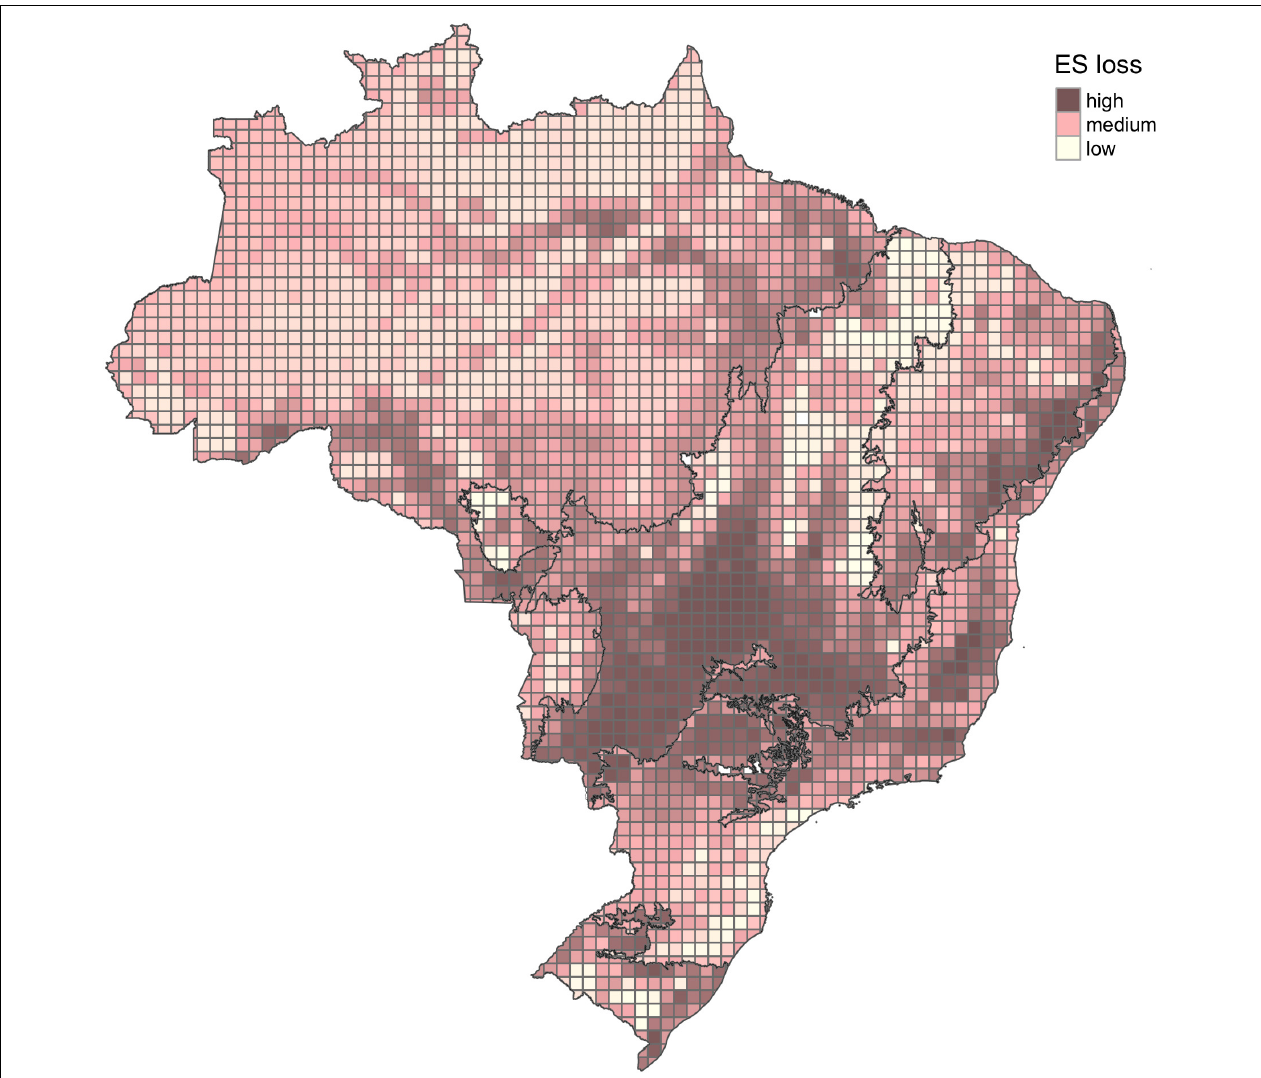
FIGURE 2 | Loss of ecosystem services (ES) potentially provided by bats in Brazil. Classes (high, medium, low) considering the land use for 2020.